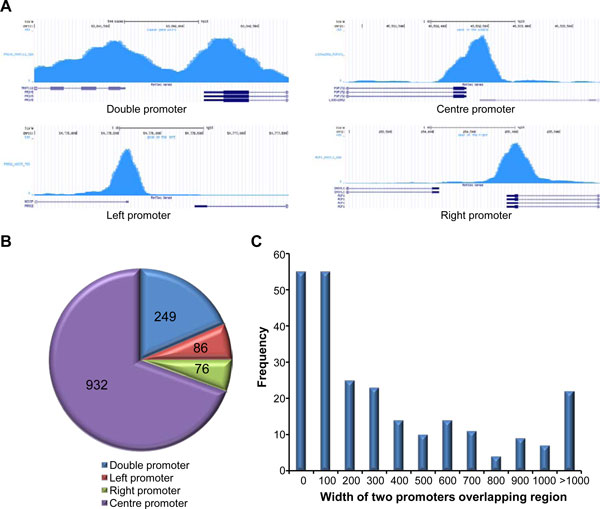
Identification of promoters in bidirectional regions. (A) 4 types of promoters. The RPol II binding pattern of 3 types of promoters, double promoter, centre promoter, left promoter and right promoter, showed in UCSC genome browser. (B) The number of identified 4 types of promoter. (C) Histogram illustrating width of overlapping regions of 2 promoters.